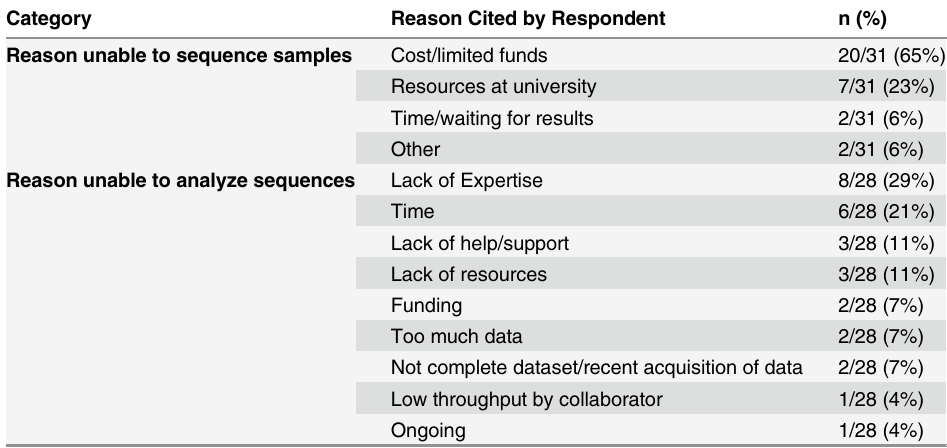
Table 3. Reasons respondents are unable to sequence samples and analyze sequences ( All Users ).